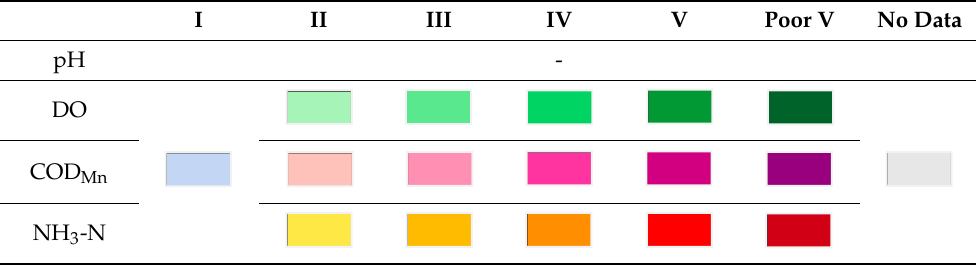
Table 2. Qualitative colors for ranking the primary water quality indices.